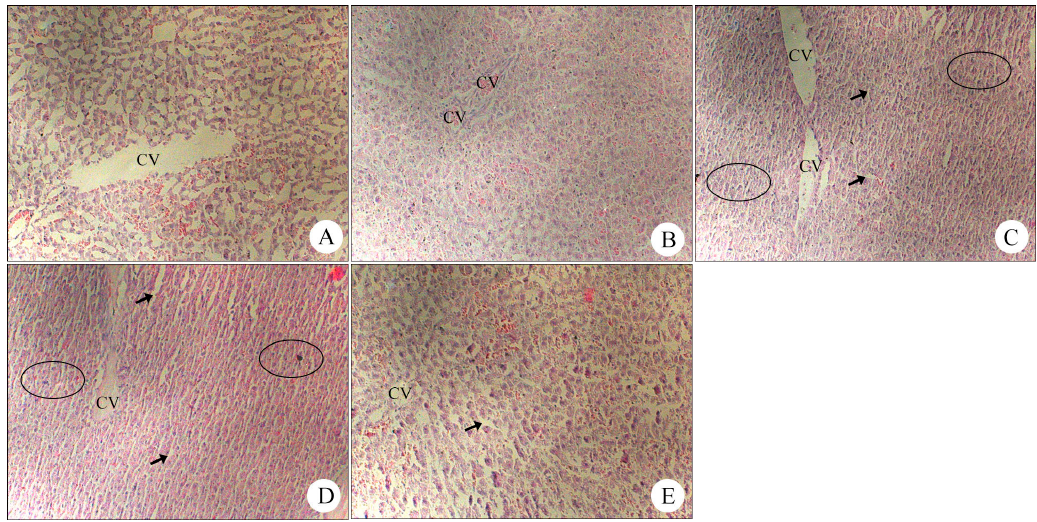
Figure 6. Histopathology of liver samples after treatment with different concentrations of volatile oil from Blumea balsamifera (BB oil) wound bearing rats. ( A ) Group B1: Control (the blank group) showed normal liver structure. ( B ) Group B2: Olive oil (vehicle) showed diffused vacuolar changes. ( C ) Group B3: BB oil (100% w/v) 1000 mg/kg showed diffused vacuolar changes; hepatocytes appeared pale with small discrete cytoplasmic vacuoles (arrow), displaying clear cytoplasm and pyknotic nuclei (circles). These results suggested an early mild hepatocellular necrosis; however, the lesions were reduced compared with A3 (normal group). ( D ) Group B4: BB oil (50% w/v) 1000 mg/kg showed diffused vacuolar changes and appeared pale with small discrete cytoplasmic vacuoles (arrow). Moreover, some hepatocyte pyknotic nuclei were observed (circles). ( E ) Group B5: BB oil (20% w/v) 1000 mg/kg showed diffused vacuolar changes; hepatocytes appeared mild cytoplasmic vacuoles (arrow) and slight amounts of pyknotic nuclei